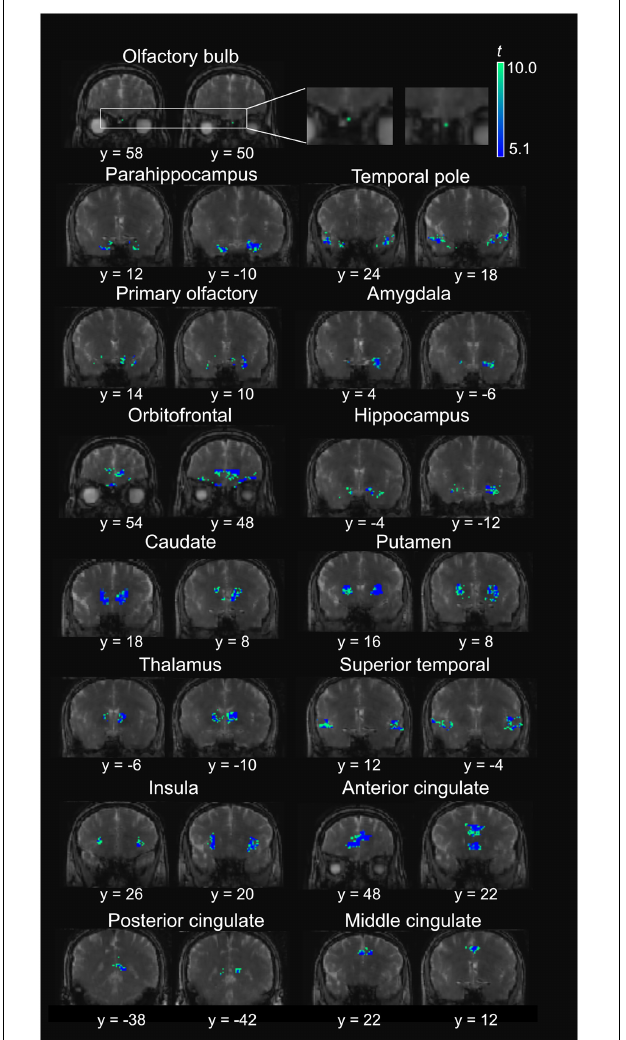
FIGURE 6 | Representative negative activation maps from T2prep BOLD fMRI scans during the olfactory stimulation from one participant. The t -scores of significantly negatively activated voxels are overlaid on the T2prep BOLD images from the same participant. Two slices are shown for each ROI. But the entire activated cluster in each ROI covered more